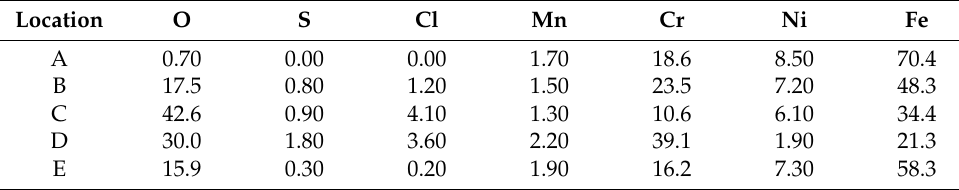
Table 3. Results of the EDS analysis of the corroded regions